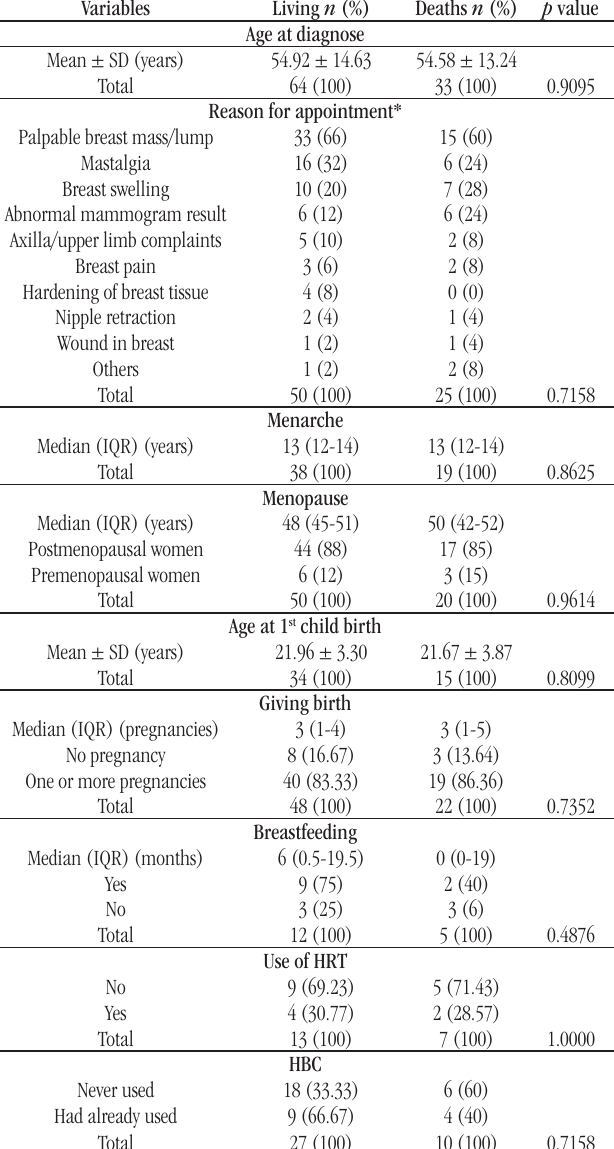
taBLE 4 − Clinical characteristics of the triple-negative invasive breast cancer distributed by outcome Variables Living n